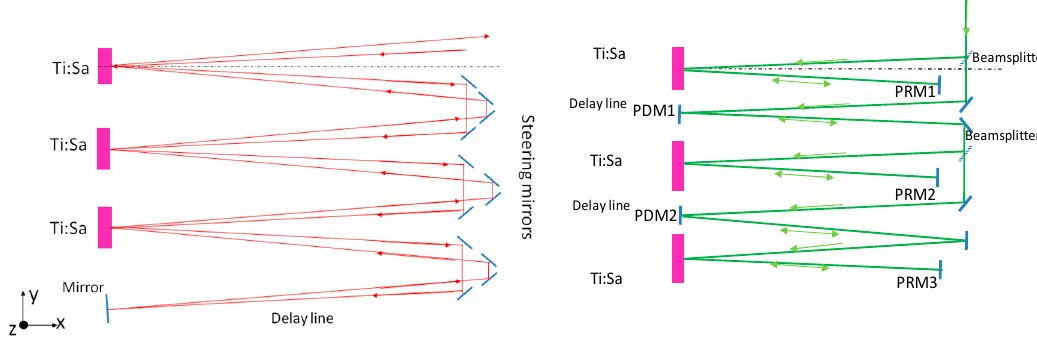
Figure 3. ( Left ) amplified beam path through the Ti:Sapphire disks. Pump beams are not represented for clarity. ( Right ) pump beam path. Drawings not in scale, with angles exaggerated for clarity.